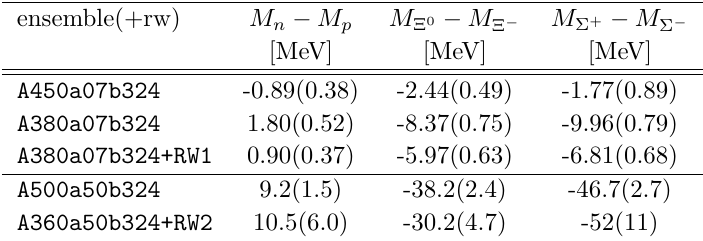
Table 8 . For each ensemble (possibly with mass reweighting): baryon mass differences. Values in MeV are obtained by using the reference value (8 t 0 ) 1 / 2 = 0 . 415 fm